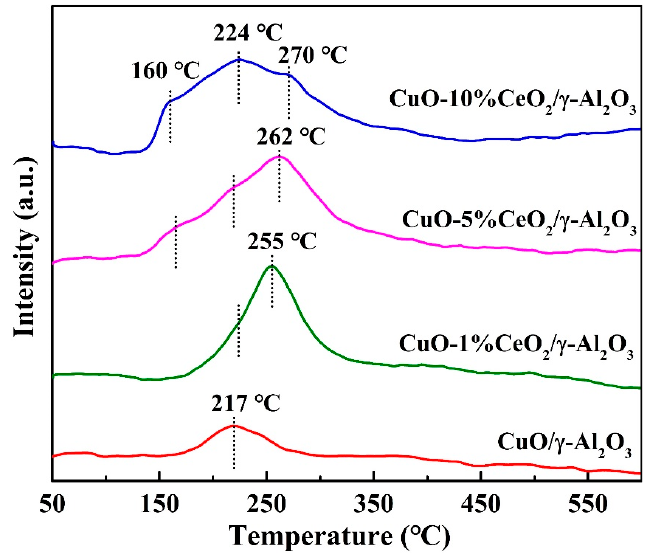
Figure 5. H 2 ‐ TPR profiles of CuO/ γ ‐ Al 2 O 3 , CuO ‐ 1% CeO 2 / γ ‐ Al 2 O 3 , CuO ‐ 5% CeO 2 / γ ‐ Al 2 O 3 , and CuO ‐ Figure 5. H 2 -TPR profiles of CuO/ γ -Al 2 O 3 , CuO-1% CeO 2 / γ -Al 2 O 3 , CuO-5% CeO 2 / γ -Al 2 O 3 , and 10% CeO 2 / γ ‐ Al 2 O 3 . CuO-10% CeO 2 / γ -Al 2 O 3 . Appl. Sci. 2022 , 12 , 10101